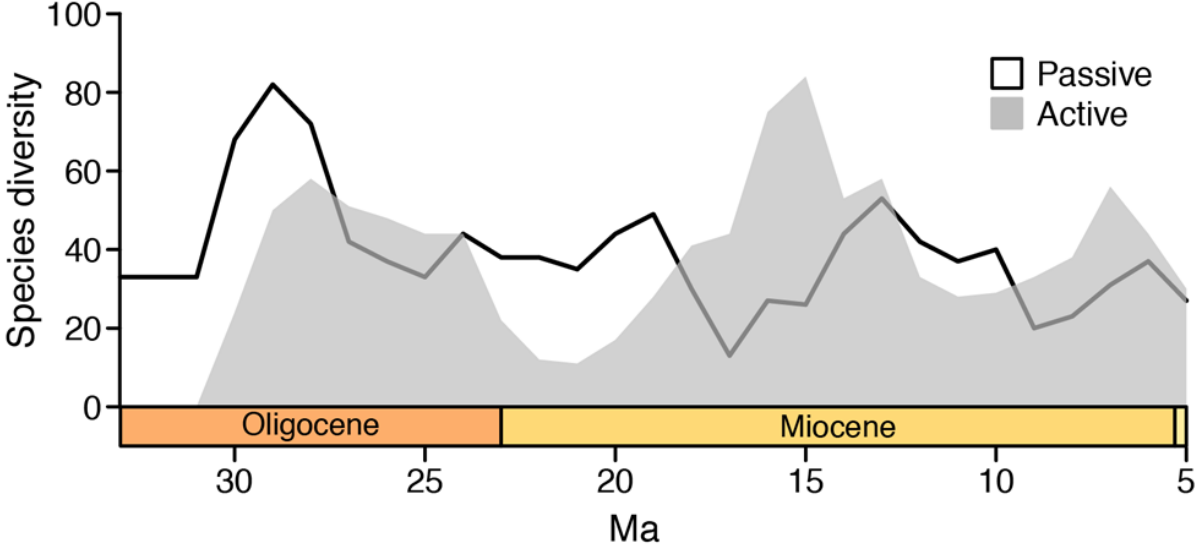
Figure 2. Rodent species richness through time for 1-myr time bins for the topographically complex, tectonically acti- ve region (west of the Rocky Mountain Front Range) in transparent gray and for the low-relief, tectonically passive region (Great Plains and east) outlined in black. Peak mammal diversity for the active region coincided with intense tectonic extension and global warming during the middle Miocene. The passive region did not show a corresponding peak during that interval. Both records were dynamic through time, and the topographic diversity gradient was only intermittently present. Species diversity was calculated assuming that species ranged through first and last occurren- ces within a region and using the methods of Finarelli and Badgley (2010). Fossil-occurrence data were obtained from the MIOMAP database for North American fossil mammals (Carrasco et al. 2007). (Figure modified from Smiley, in